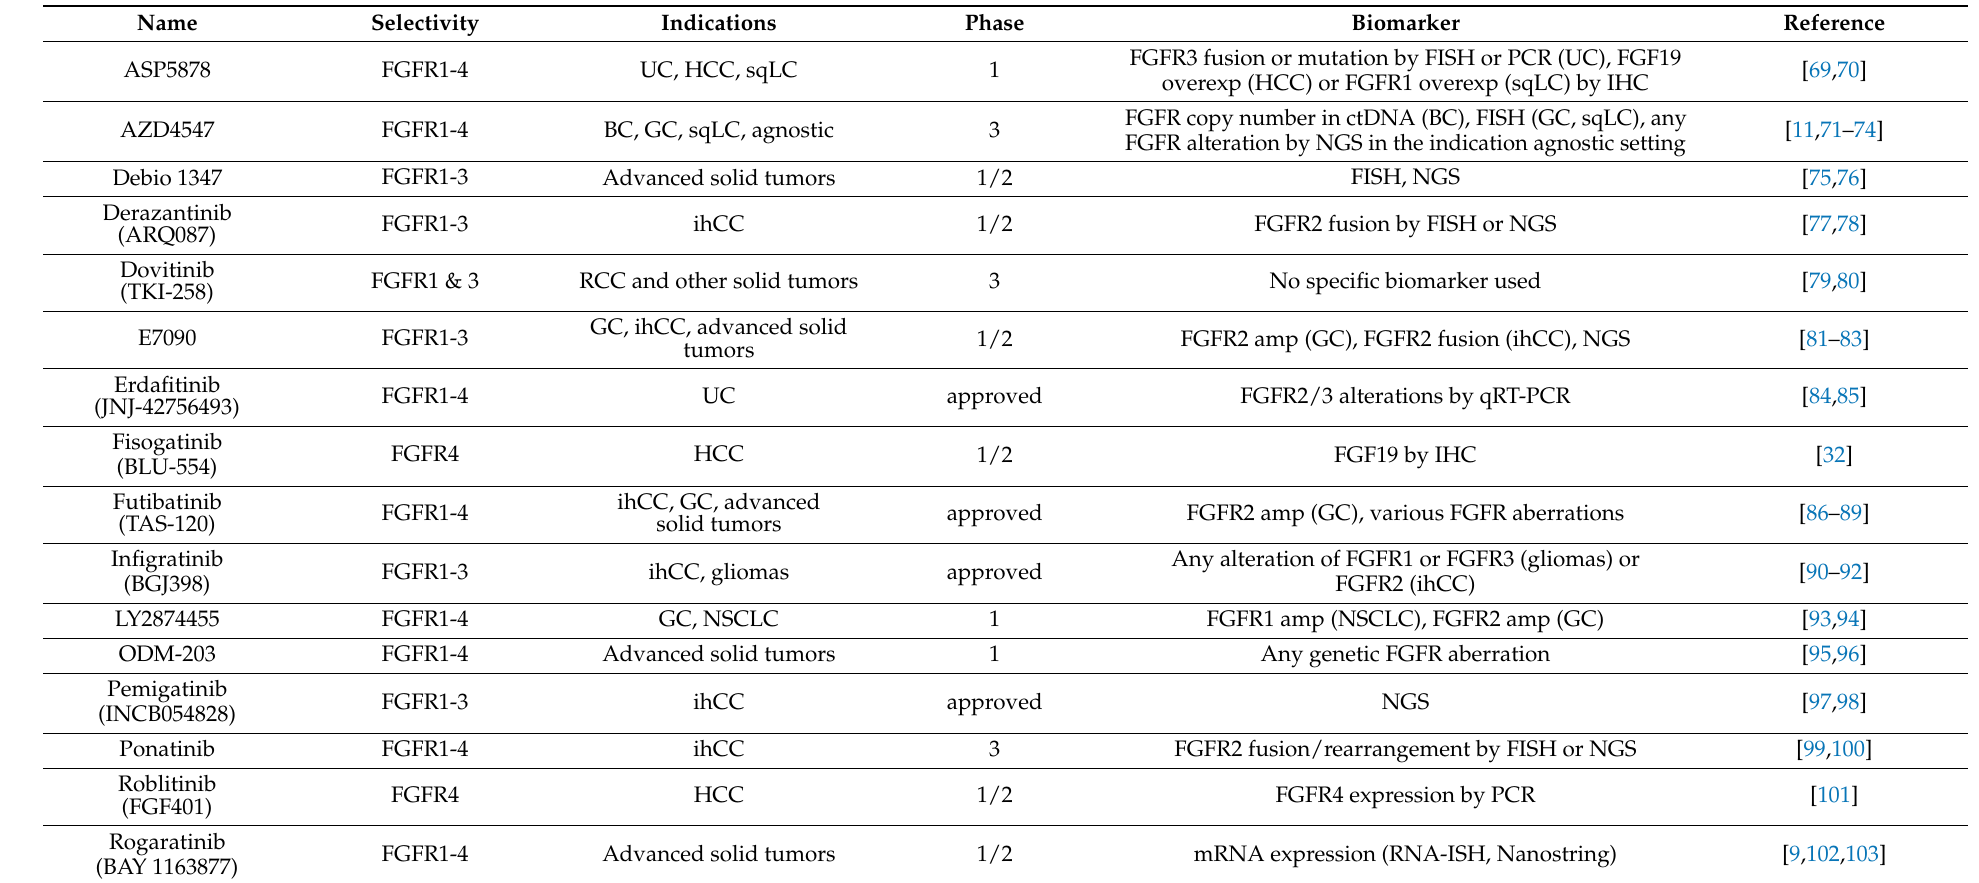
Table 1. Clinically tested FGFR